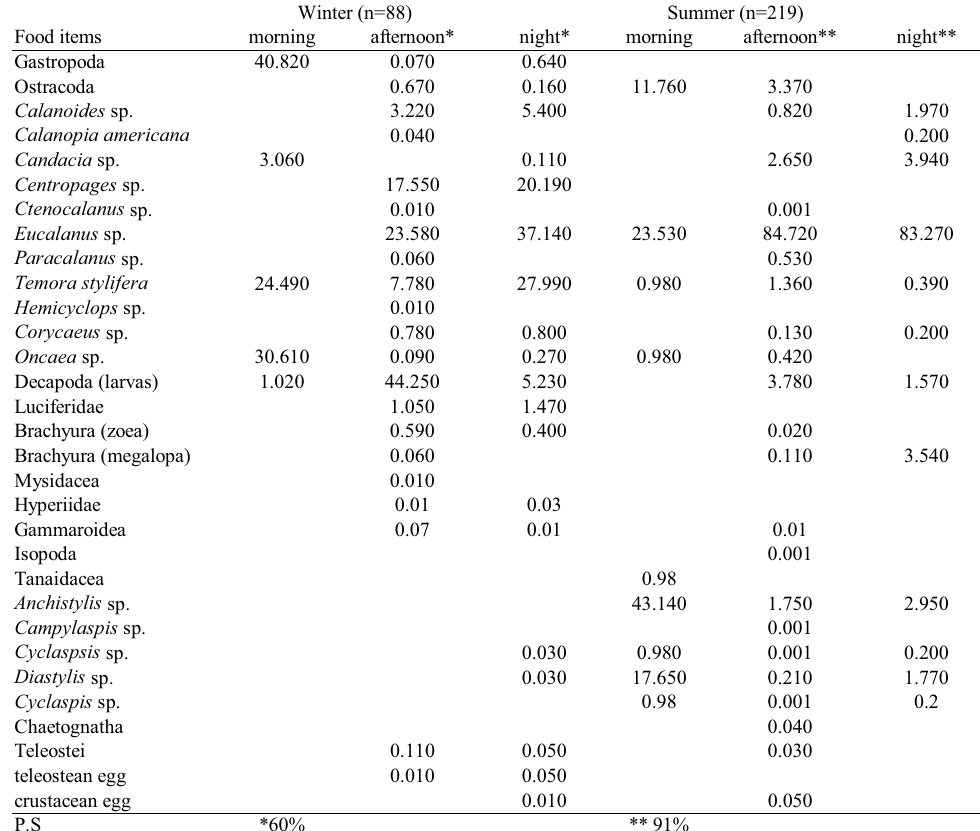
Table 3. Feeding index of food items of Trachurus lathami collected in winter and summer from Brazilian shelf off Ubatuba. *and **Percent similarity index (PS) >